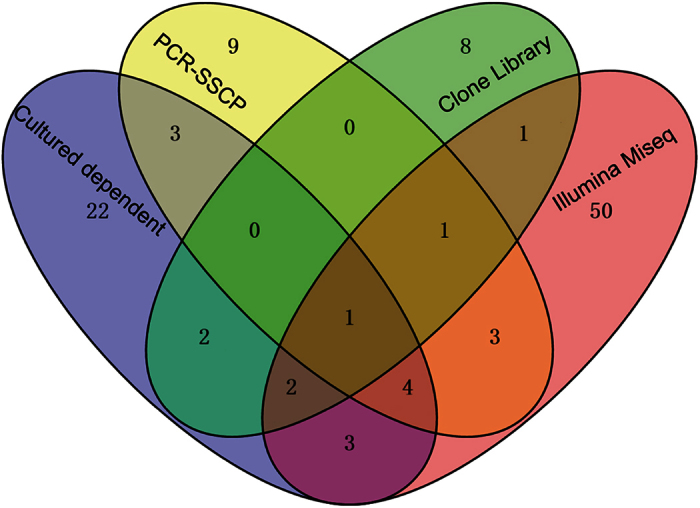
Comparison of the endogenetic fungal communities investigated using different methods.Different colors revealed the results in the current study and previously published studies using other methods for the analysis of the diversity of the endogenetic fungal communities, i.e., culture-dependent method5, PCR-SSCP26 and clone library9. The numbers indicate the shared genera in the studies.